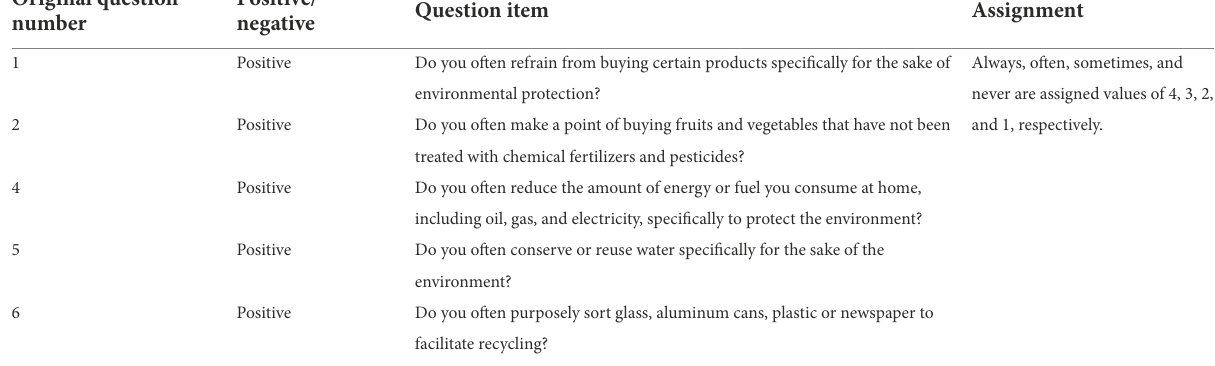
TABLE 1 Items related to green consumption